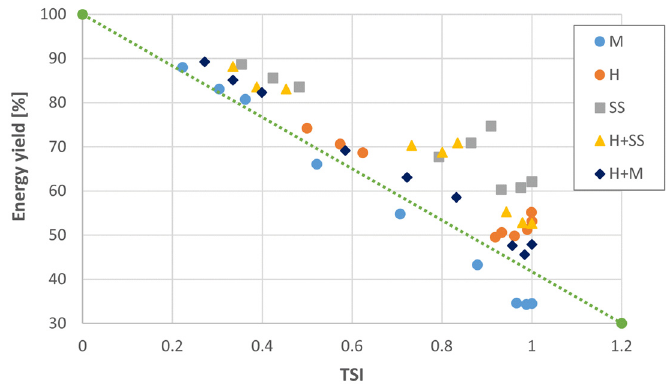
Figure 5. TSI and energy yield with respect to torrefaction temperature and time.